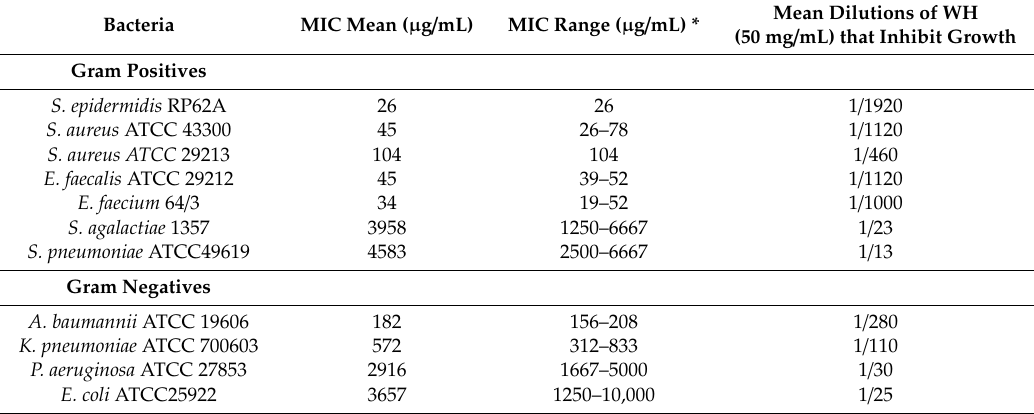
Table 1. Minimal inhibitory concentrations (MICs) of WH and respective dilution factors against various bacteria. * MIC range represents the minimum and maximum MIC values obtained in the di ff erent replicates. Mean Dilutions of WH MIC Mean ( µ g / mL) MIC Range ( µ g / mL) * (50 mg / mL) that Inhibit Growth